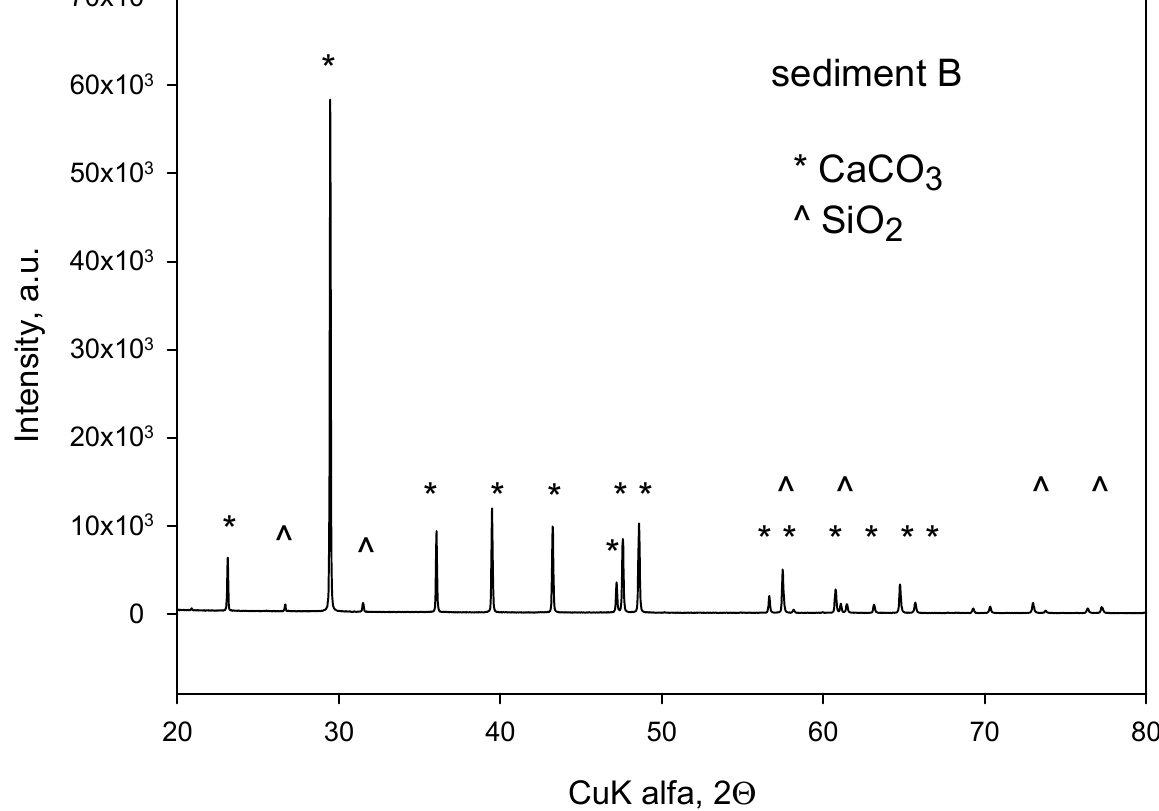
Figure 1. XRD diffractogram of sediment B (after thermal treatment at 500 °C).